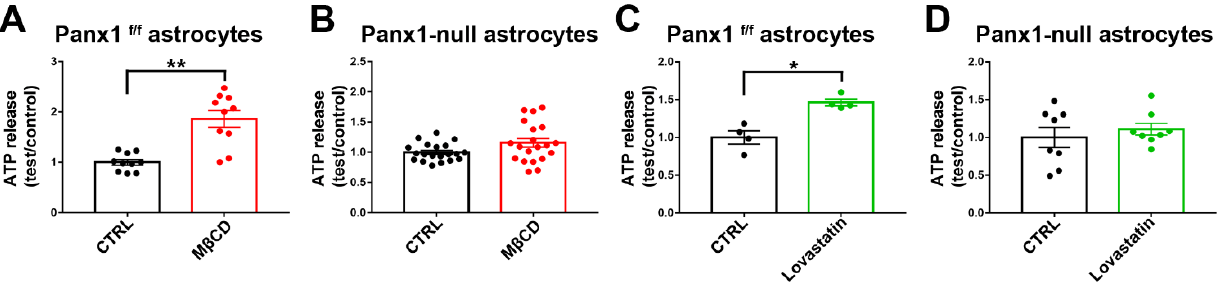
Figure 10. Panx1 channels mediate ATP release from cultured cholesterol depleted astrocytes. His- tograms showing the ATP release from cultured Panx1 f/f and Panx1-null astrocytes induced by cho- lesterol depletion with 5 mM M β CD ( A , B ) and 10 µM lovastatin ( C , D ). Bar histogram of the mean ± SEM values of ATP release from cultured Panx1 f/f and Panx1 null astrocytes induced by cholesterol depletion. p values were obtained using Mann–Whitney tests. Data are from 2–3 independent ex- periments. * p < 0.05, ** p < 0.01.